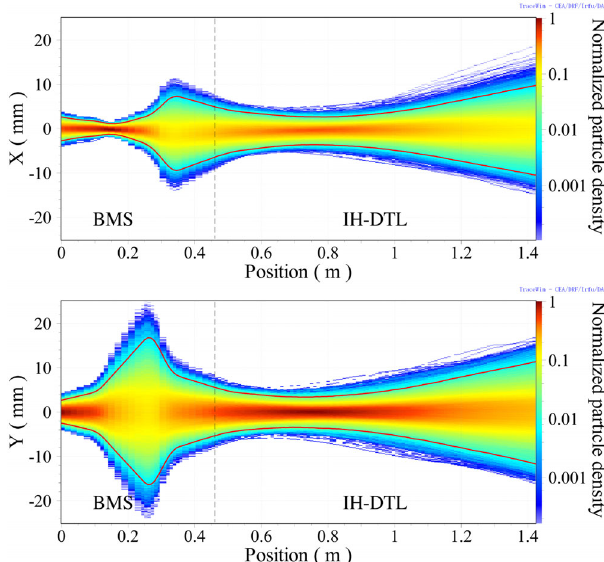
FIG. 11. Simulated beam envelope inside the BMS and the IH-DTL cavity after steerer correction, with the beam distribution at the exit of the RFQ as input and the alignment error of the BMS taken into account. The red curve represents the 99% beam envelope.